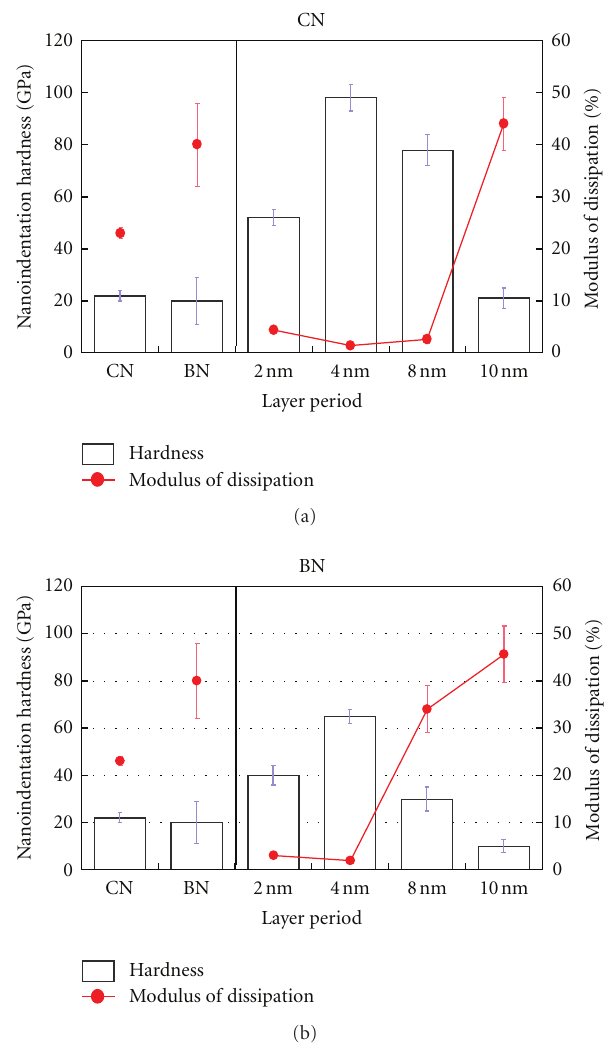
Figure 7: Nanoindentation hardness and modulus of dissipation of (a) (CN/BN)n and (b) (BN/CN)n films.